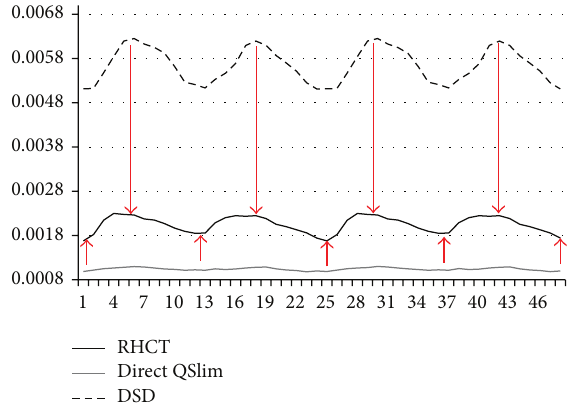
Figure 15: Simplification error per frame for a 2000-triangle approximation of a galloping horse.